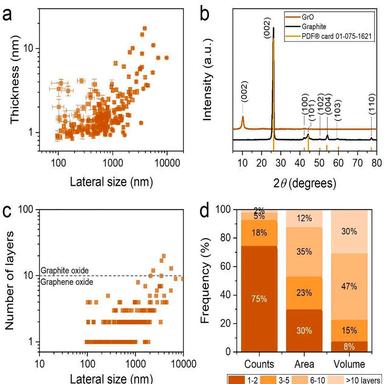
(a) GO nanosheet thickness versus lateral size. (b) GrO and pristine graphite XRD diffractograms, and graphite 2H PDF® card 01–075-1621. Plots of (c) number of layers as a function of the lateral size of the GO nanosheets, and (d) distribution of the nanosheet number of layers by the number of flakes, area, and volume.